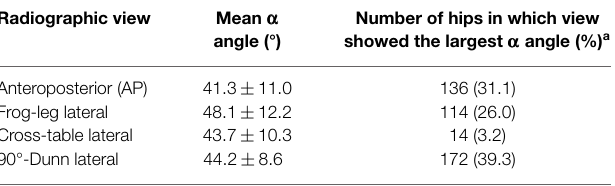
TABLE 2 | Variation of ααα -angle measurements by radiographic view